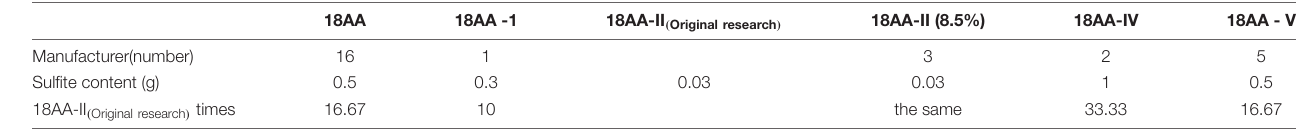
TABLE 1 | Sulfite contents of the five formulations of the 27 manufacturers and 18AA-II original research .